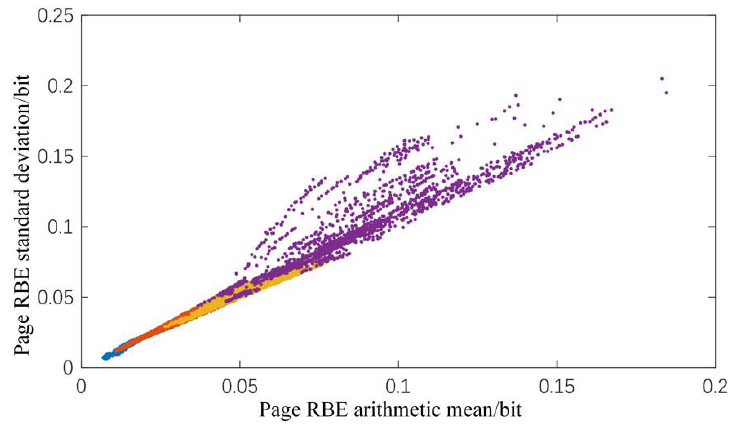
Figure 8. The distribution of the arithmetic mean and standard deviation of the sample points of the data set.